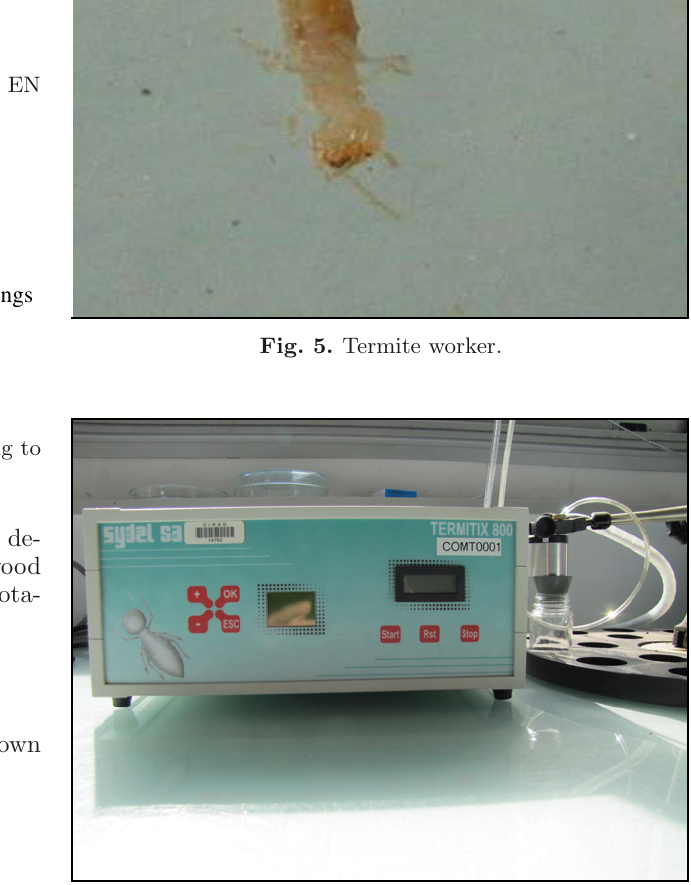
Fig. 6. Apparatus to count the termites, further so called